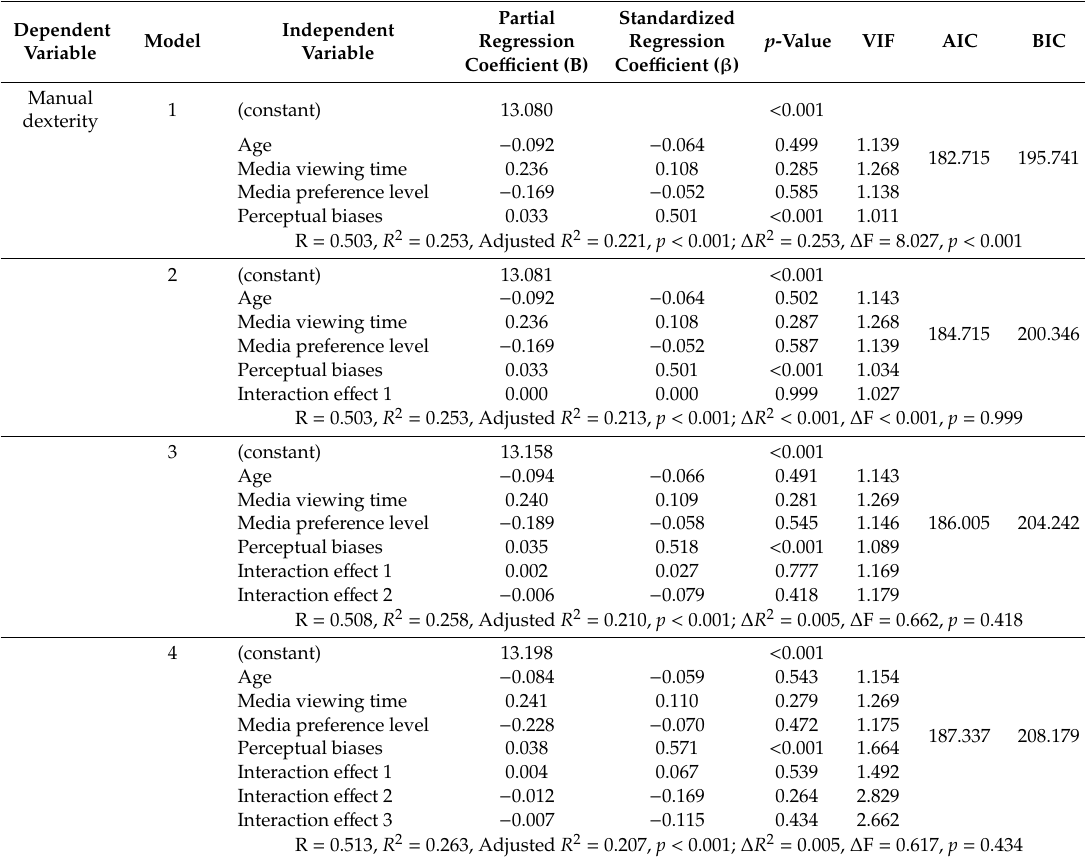
Table 4. Hierarchical multiple regression analysis